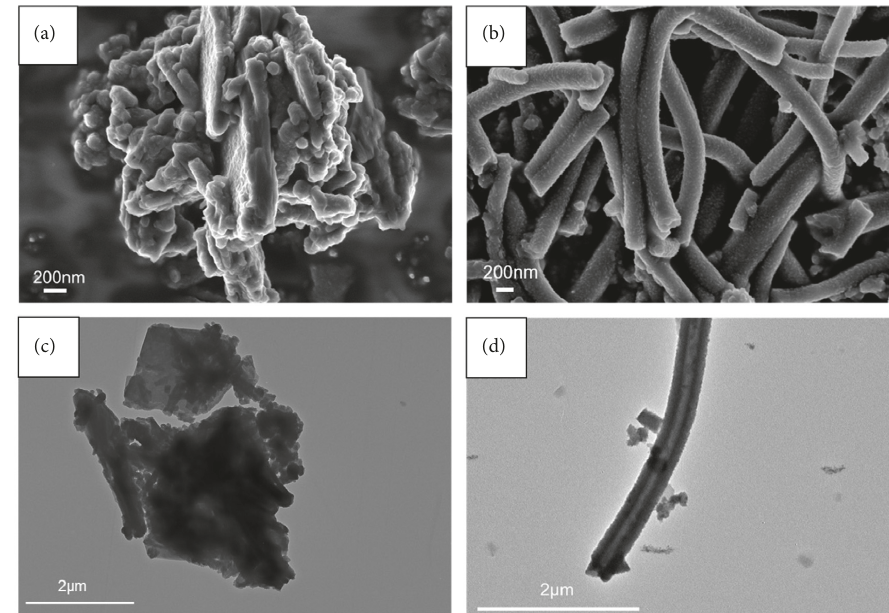
Figure 1: FESEM and TEM images of PANI (a, c) and GluP (b, d), respectively.